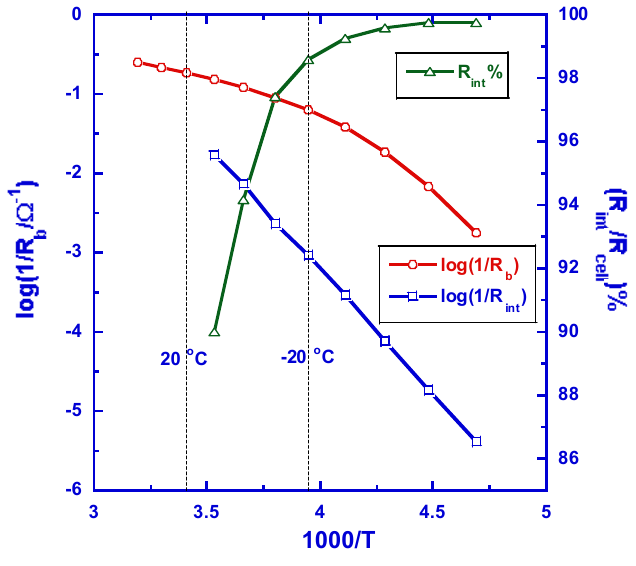
Figure 4. The comparison of resistances generated by interphasial and the bulk electrolyte during the Li ion cell operation. Rb, Rint and Rcell represent the bulk (electrolyte), interphasial and the total cell resistance, respectively (reproduced with permission from the Elsevier Encyclopedia of Electrochemical Power Sources, ©Elsevier, November